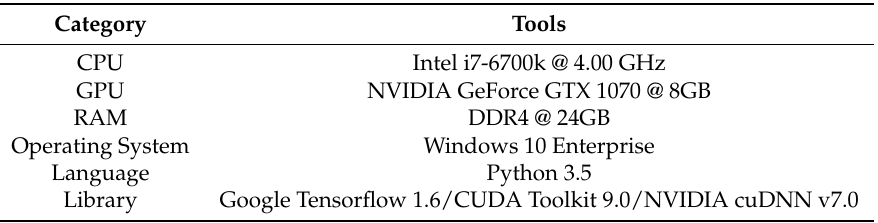
Table 2. Server system configuration and framework.